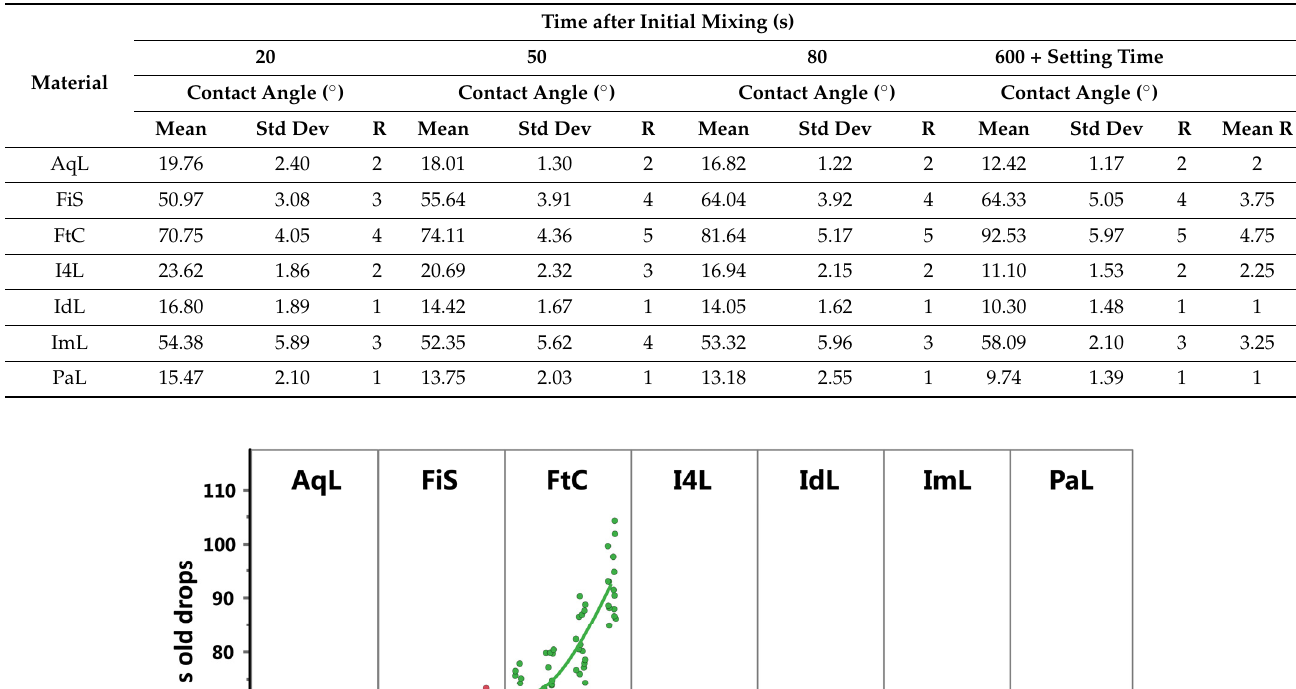
Table 6. Results from the contact angle measurements (in ◦ ) was used to determine the wetting behavior. Ranks had a statistical difference within each time group.